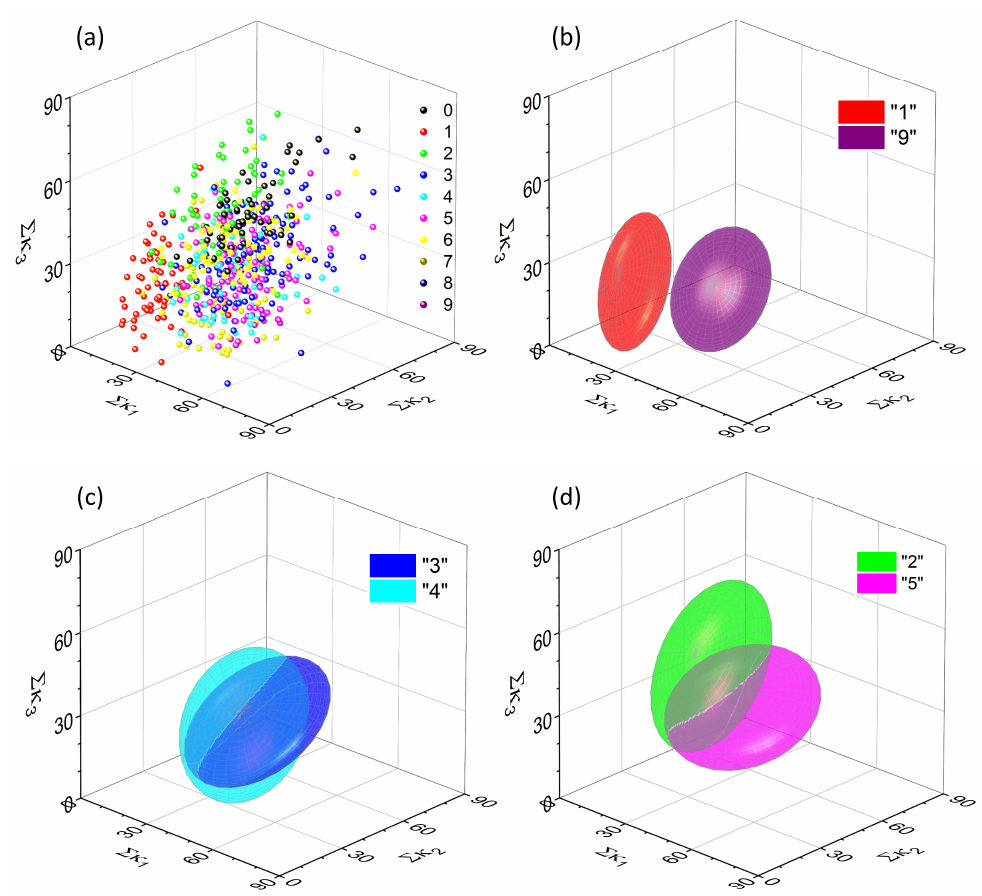
Figure 6. A complete collection of input data points (before feeding them into the single-node neural network) for a set of 600 handwritten digits in the one, arbitrary chosen 3D projection ( a ) and an example of a relatively well-separated pair, which is associated with digits “1” and “9” ( b ). Other ellipsoids overlap significantly, e.g., those for digits “3” and “4” ( c ) or “2” and “5” ( d ). It can be noticed that only two pairs are completely separated, whereas three others are close to complete separation. Most of these cases concern digit “1” which is substantially different (when the symmetry and number of pixels are taken into account) from any other handwritten digit.